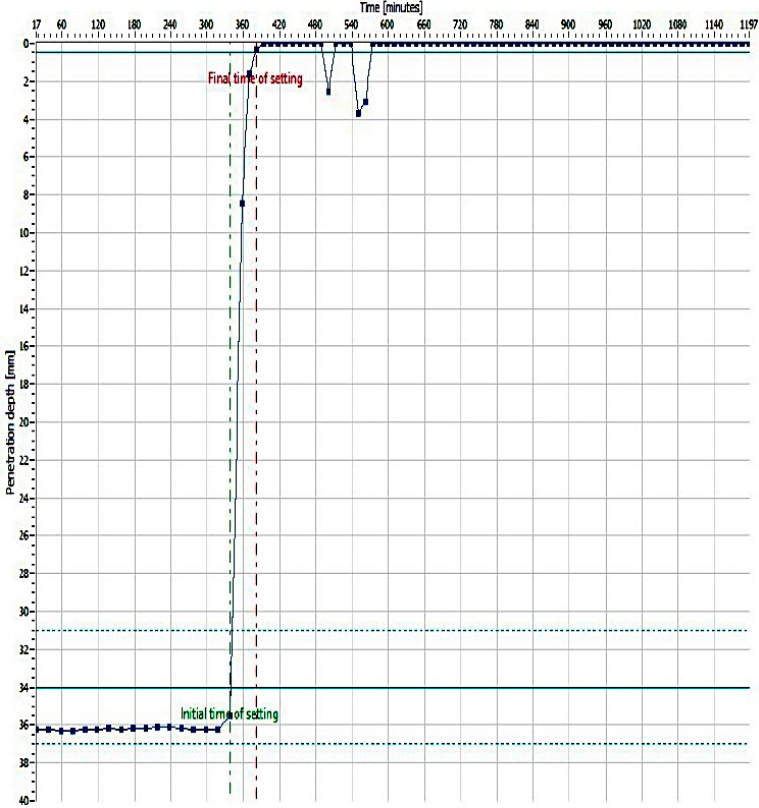
Figure 12. The setting process of the cement slurry with the addition of 20% Hblock (short transition time) Composition No. 5.